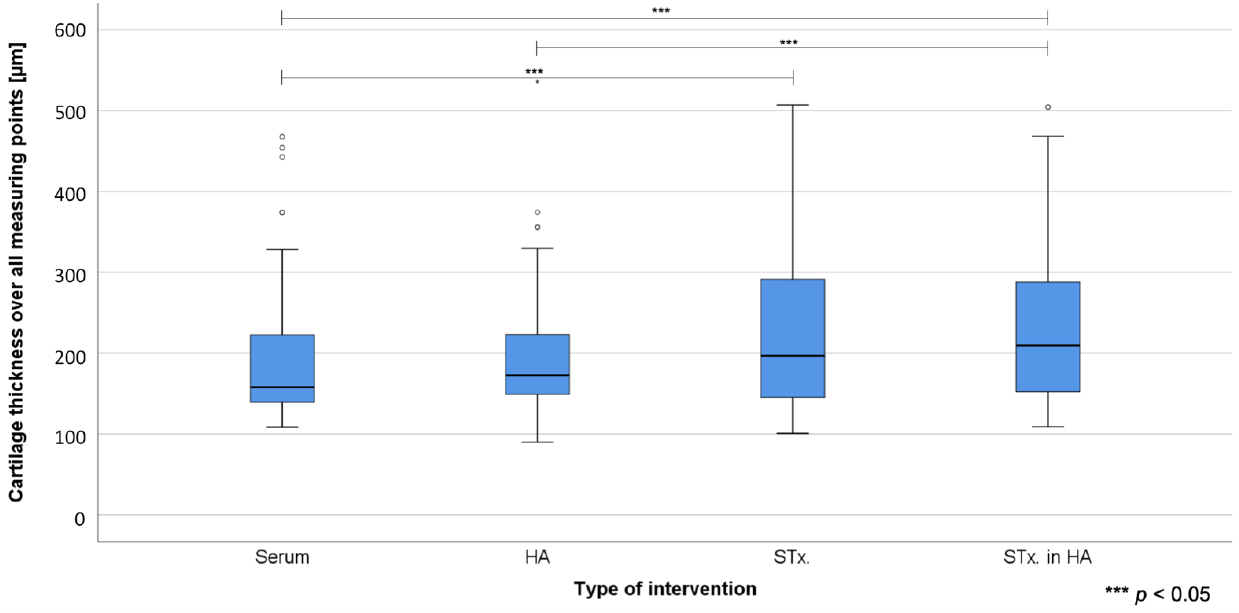
Figure 1. To objectify the cartilage thickness measurements, a line grid (black) was used to define random measuring points on the cartilage surface. At these points the thickness measurement (yellow) was finally taken, each right angled to an imaginary tangent (dotted).